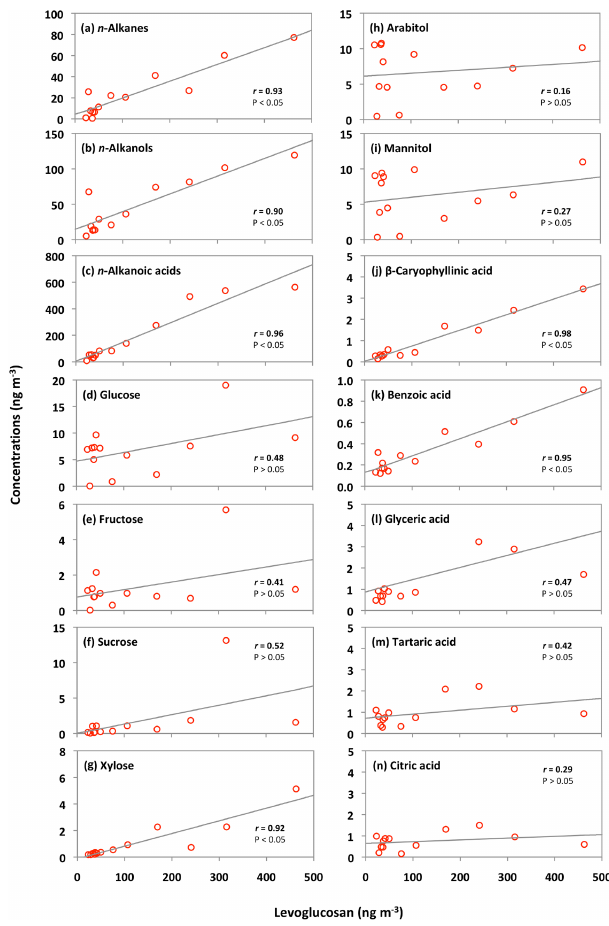
Figure 8. Correlations of organic compounds with the biomass burning tracer levoglucosan in the Alaskan aerosol samples.